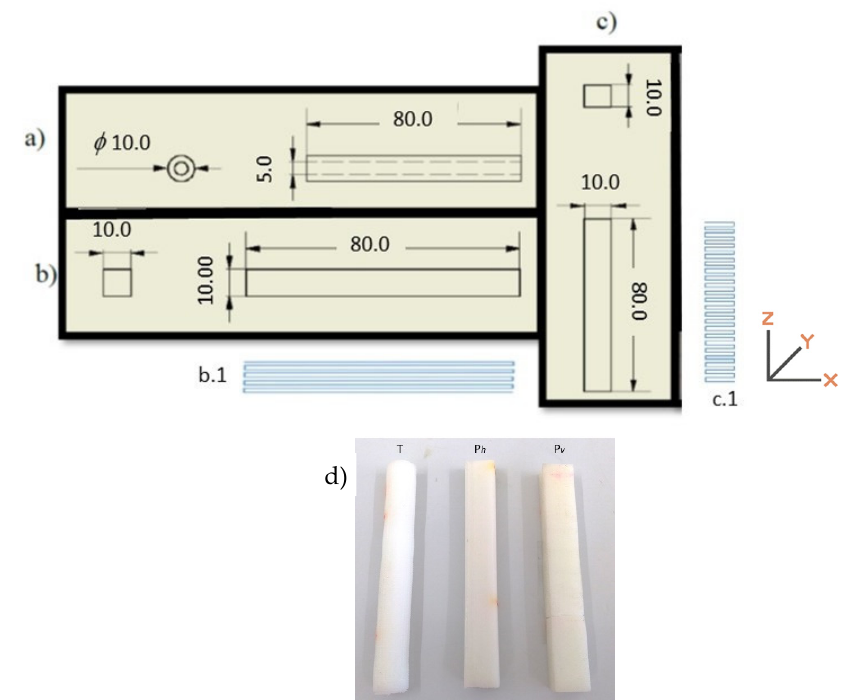
Figure 1. Schematic representation of the dimensions (in mm) of the printed specimens in the form of tube ( a ) and parallelepiped ( b , c ) with the build orientation for the two different parallelepiped forms ( b.1 and c.1 ); ( d ) digital macrographs of the three printed specimens. For all the samples, the main printing parameters were kept constant: nozzle diameter of 0.4 mm, nozzle temperature at 80 °C, spindle rotation speed of 22 rpm, and printing speed of 25 mm·min − 1 .